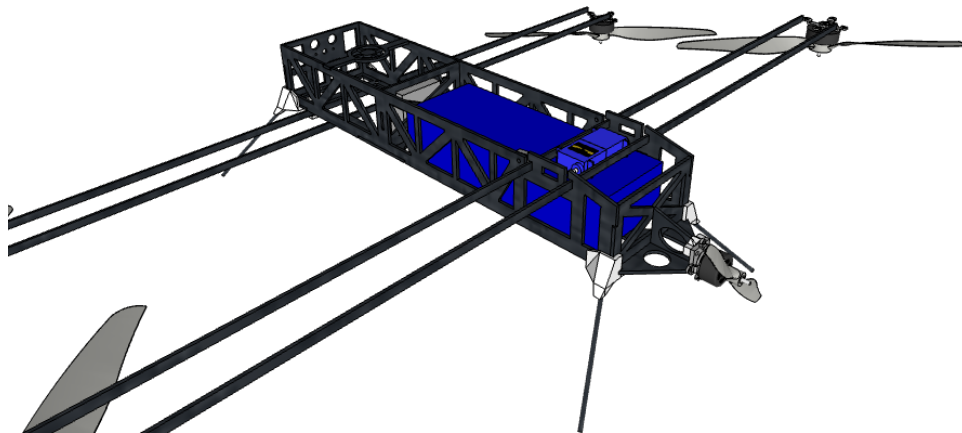
Figure 13. The early Elka1Q fuselage mainly was made of carbon-fibre elements, but it was still not rigid